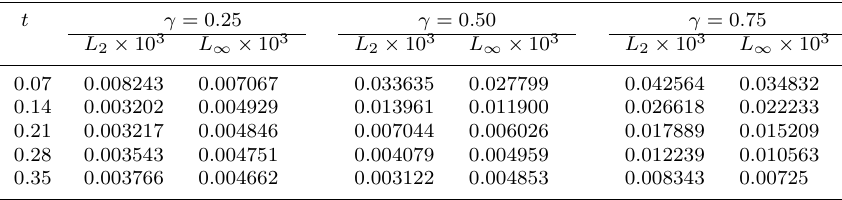
Table 4. The comparison of the error norms of the diffusion problem for M = 40, ∆t = 0 . 00007 and t f = 0 . 35.